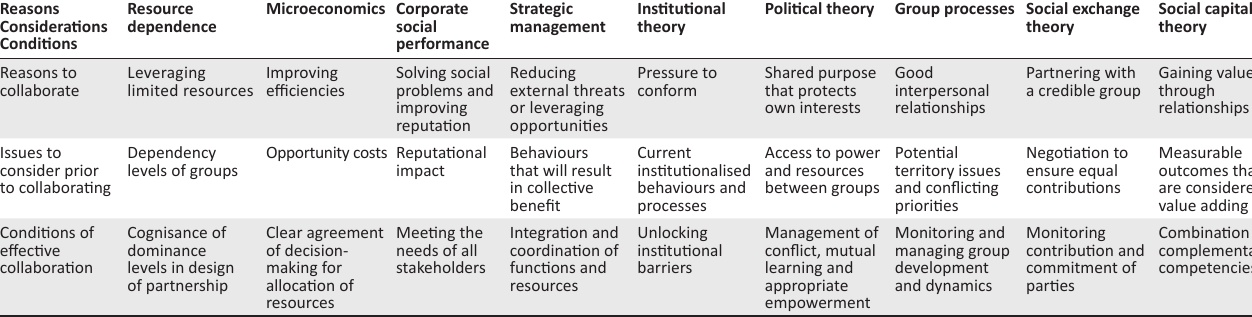
TABLE 1: Mapping theories of collaboration against reasons, considerations and